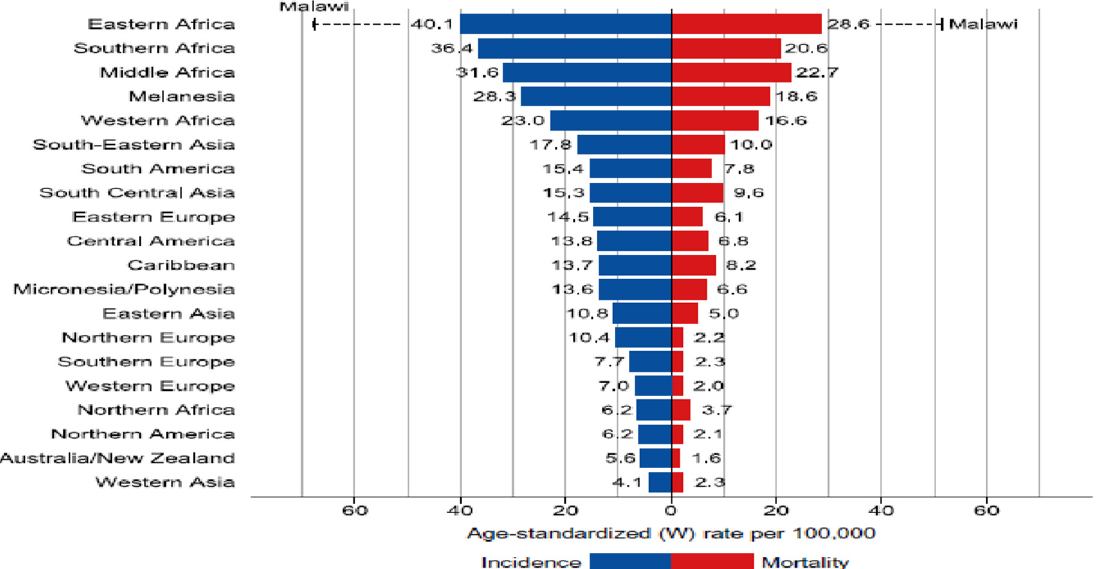
Figure 1. Mortality Age-Standardized Rates and Region-Specific Incidence for Cervical Cancer in 2020. Reprinted with permission from Ref. [1]. Copyright 2020 IARC/WHO.